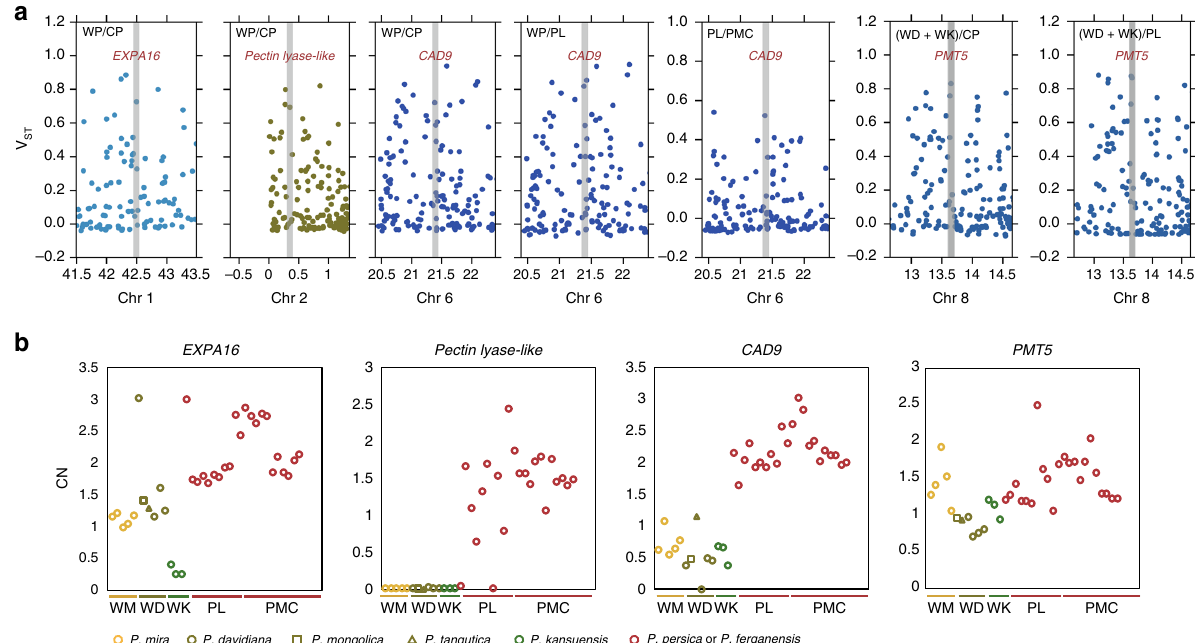
Fig. 5 CNVs involved in fruit texture and taste during peach domestication and improvement. a Manhattan plots of V ST values. Four fruit texture or taste associated candidate genes ( EXPA16 , Pectin lyase-like superfamily protein , CAD9 , and PMT5 ) (within regions exhibiting high V ST values (top 5%)) are visualized with shadows. b Copy number pro fi les of the four candidate genes with high V ST values. The selected genes and estimated copy numbers for individuals from distinct groupings are provided in each plot NATURE COMMUNICATIONS| (2018) 9:5404